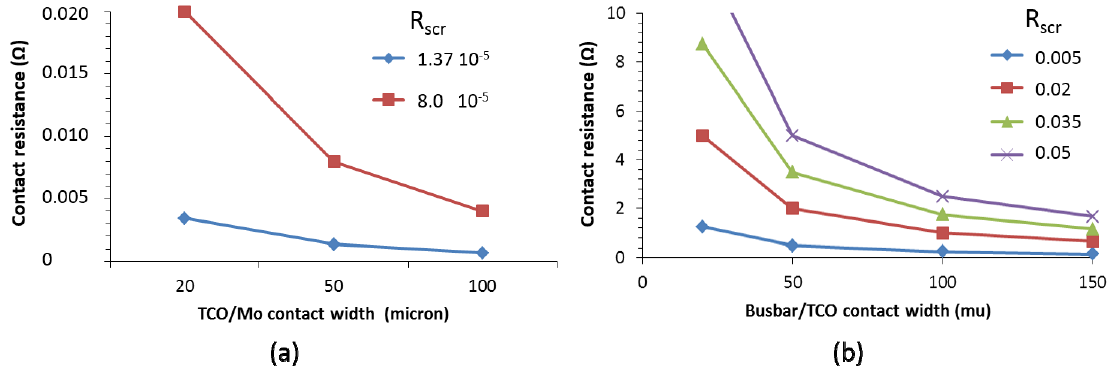
Figure 8. Contact resistance for a 1 cm 2 cell as a function of the width of the contact area between the TCO and the Mo ( a ) and the metal busbar and the TCO ( b ). The legend shows the specific contact resistance (R scr , in Ω cm 2 ). The cell length is 5 mm.